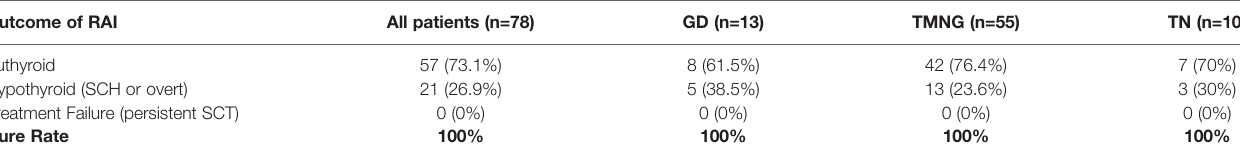
TABLE 4 | Outcome of RAI Therapy in all patients, classi fi ed by SCT aetiology. Outcome of RAI